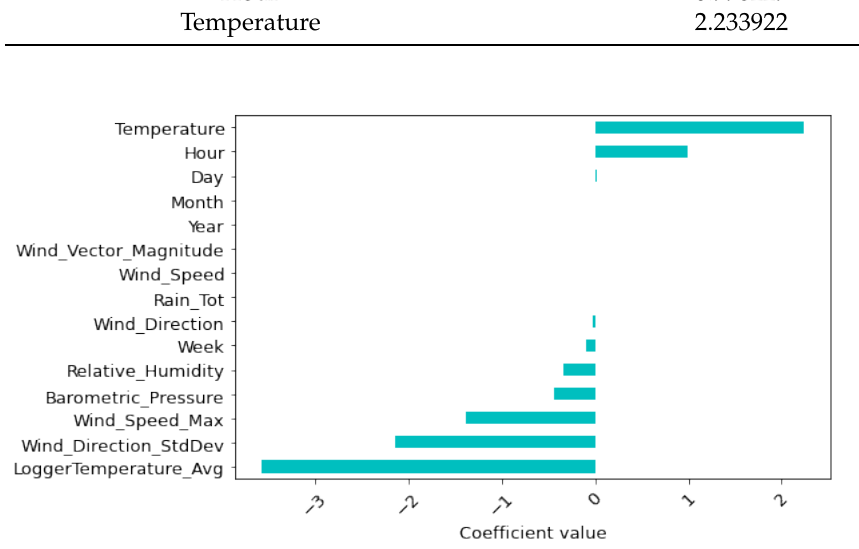
Figure 5. Selection of variables using LASSO